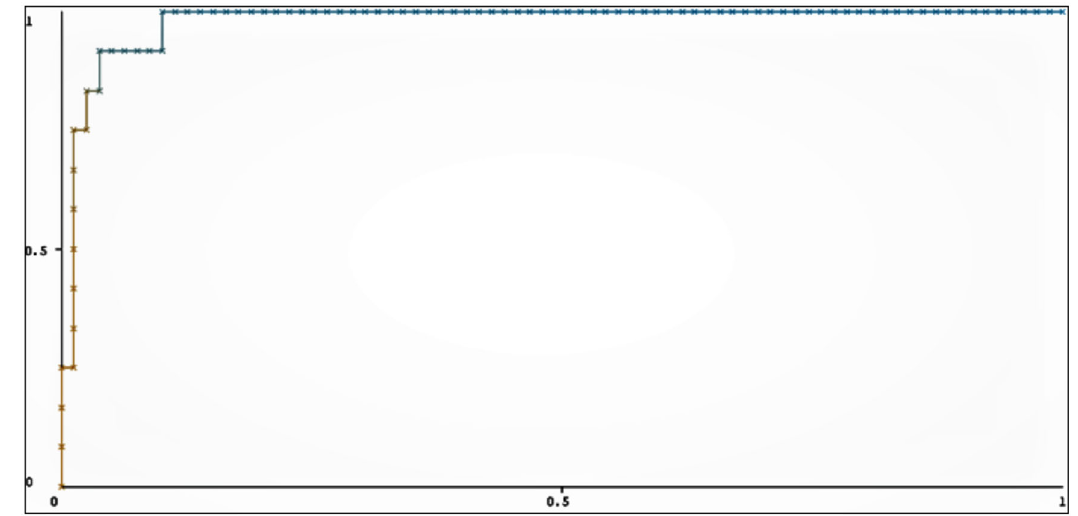
Fig. 9 The individual class-wise ROC plot for the proposed soft voting ensemble model showing the classi fi cation performance for class ‘ High ’ .